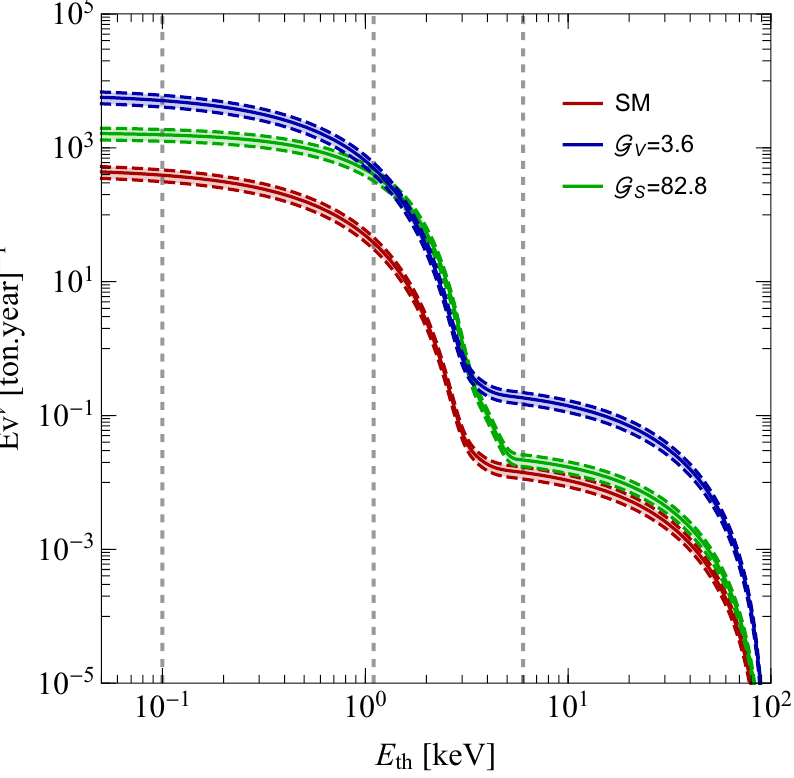
Figure 6 . Number of CNSN events per ton year for LUX-ZEPLIN as a functions of the energy threshold. In red we show the predictions for the SM and in blue (green) for the vector (scalar) model with G V = 3 : 6 ( G S = 82 : 8). The thickness of the curves represent a variation on the detector e(cid:14)ciency of 50% (cid:6) 10%.